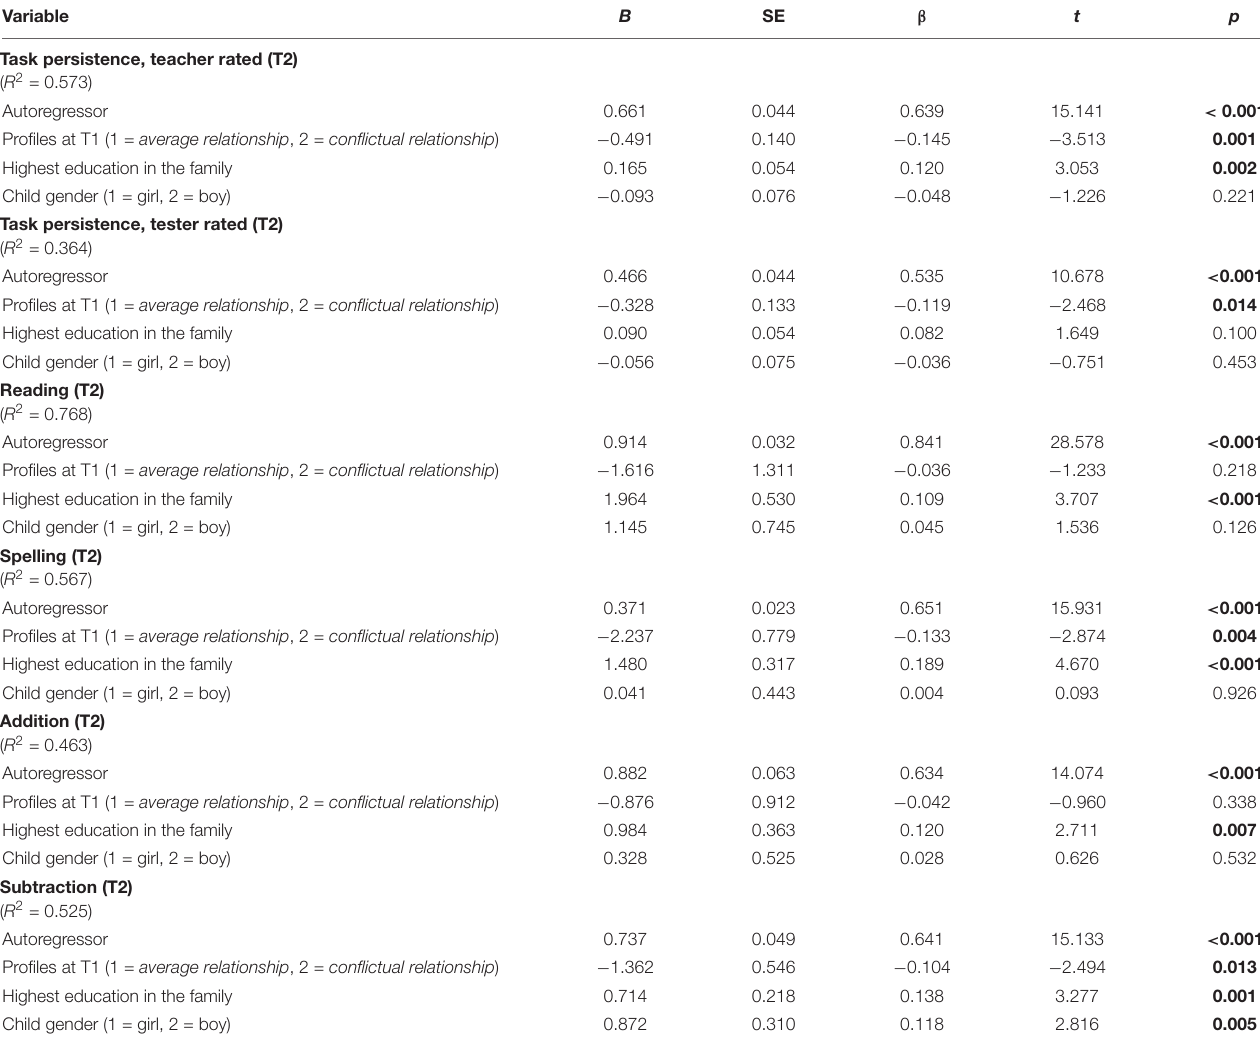
TABLE 9 | Multiple regressions predicting children’s task persistence and performance.